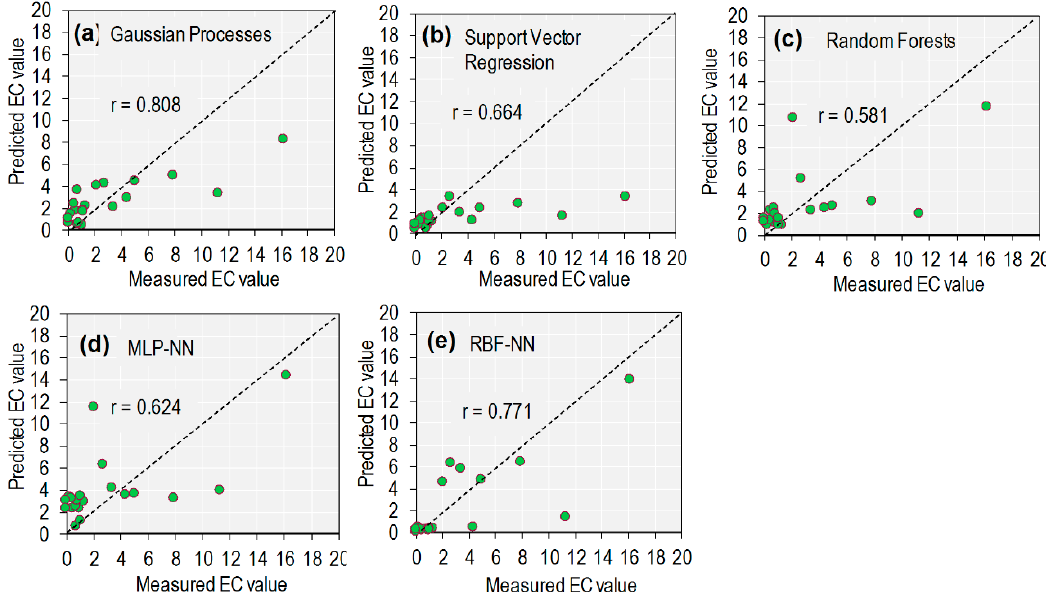
Figure 5. Correlation coefficient (r) of the measure EC and the computed EC using the validation set.